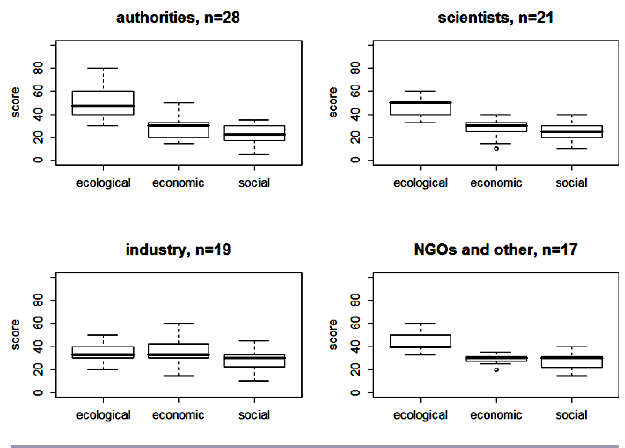
Fig. 3 . Box plot of the stakeholders’ preference scores for the three sustainability pillars and for each of the stakeholder